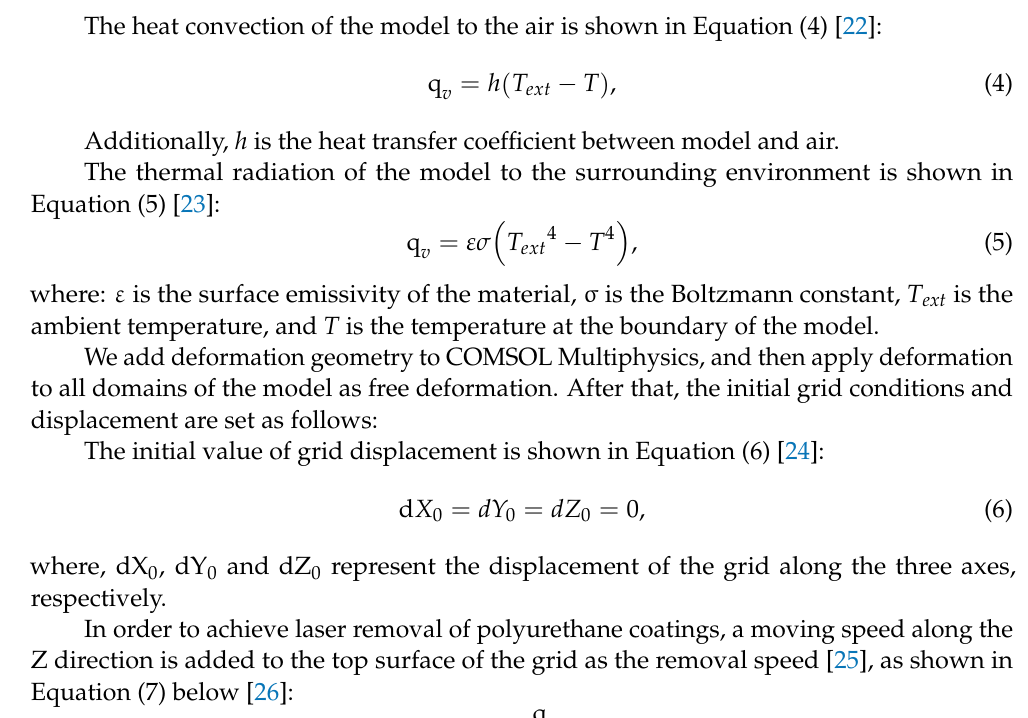
Figure 2. ( a , b ) Simulation model, and ( c , d ) diagram for Gaussian distribution of laser beam.